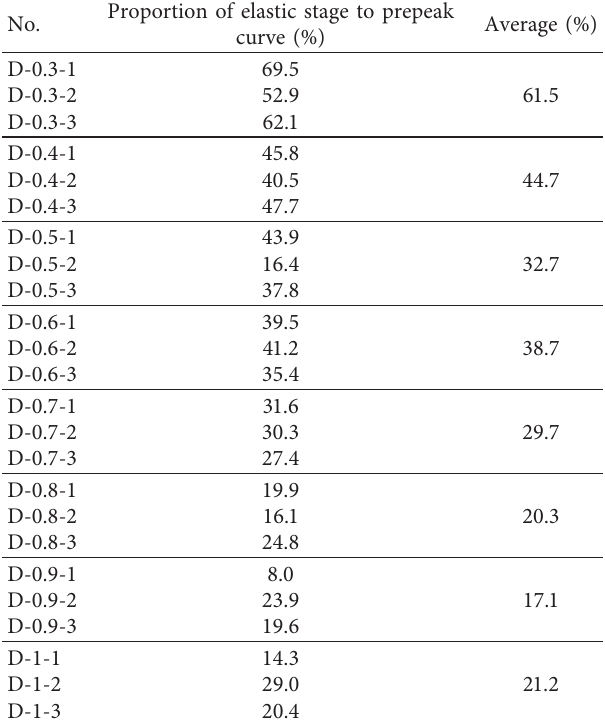
Table 2: Proportion of the elastic stage to the prepeak curve. Proportion of elastic stage to prepeak No. curve